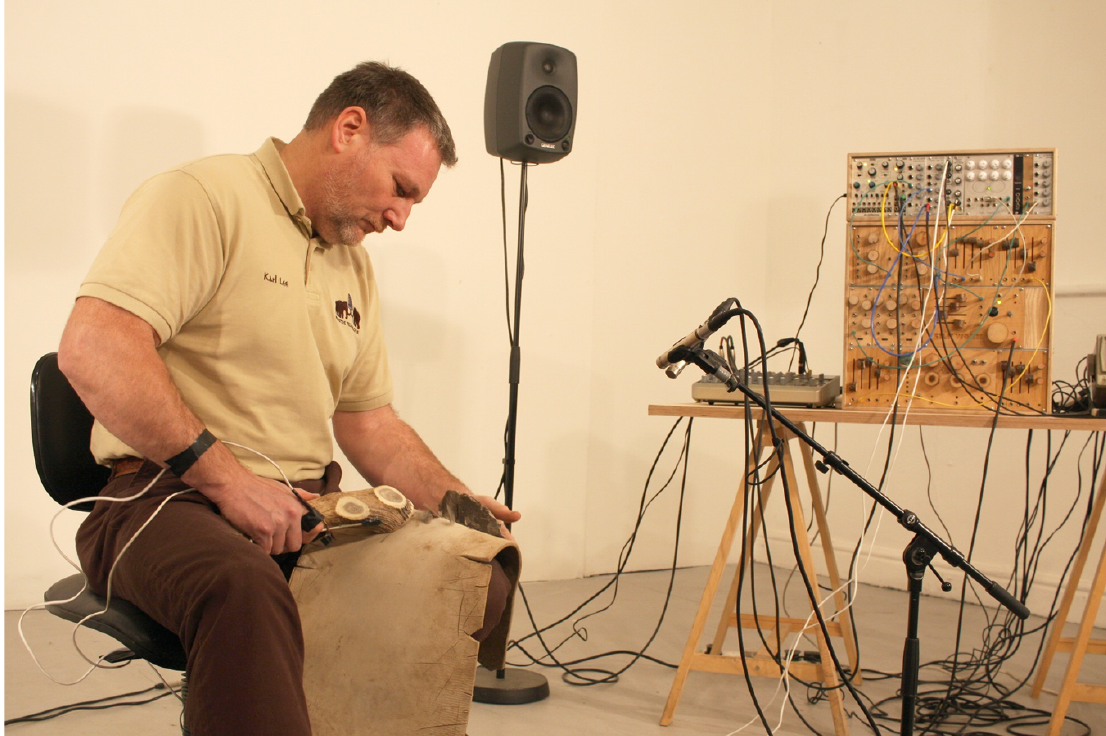
Figure 2. Stone Music: Recording a hand axe. Shaping the hand axe using an antler hammer. (Photograph courtesy of the Owl project and Simon